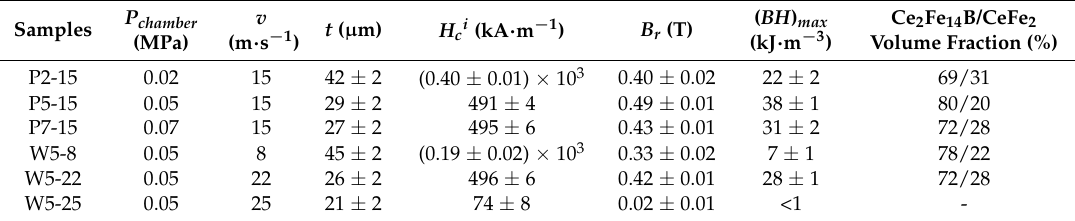
Figure 1. Schematic illustration of the melt-spinning process installed an infrared thermometer. ( A ): Cu wheel; ( B ): melt; ( C ): induction heater coil; ( D ): infrared thermometer; ( E ): ribbon; ( F ): vacuum meter. Table 1. The intrinsic coercivity ( H ci ), the remanence ( B r ), energy product (( BH ) max ), the ribbon thickness ( t ), the volume fraction of Ce 2 Fe 14 B and CeFe 2 phase of Ce 17 Fe 78 B 6 alloy at various chamber pressures ( P chamber ) and wheel speeds ( v ) .